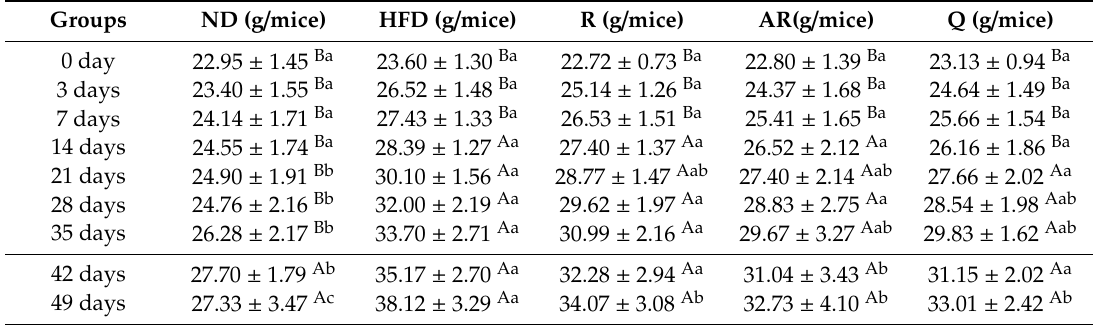
Table 2. E ff ect of experimental diets on weekly changes on body weight in